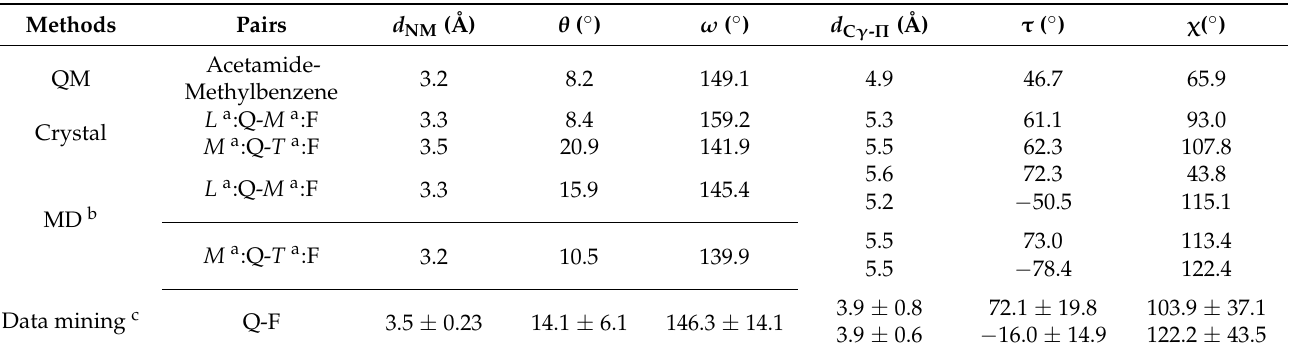
Table 1. Geometric parameters of Q-F pairs extracted from QM calculation of the acetamide-toluene complex, crystal structure and MD trajectories of peptide GPQGFO, and a non-redundant dataset of protein crystal